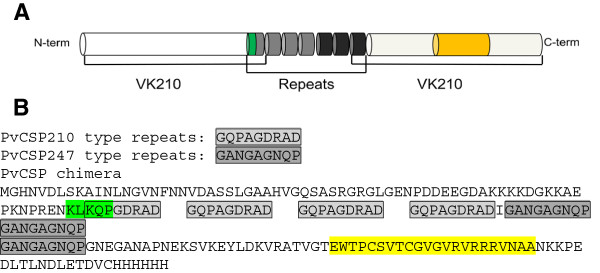
Protein structure (not drawn to scale) and amino acid sequence of the recombinant PvCSP molecule. The repeat region is flanked by N-terminal and C-terminal conserved regions based on the VK210 sequence. The central region represents four VK210 repeats (grey) and three VK247 repeats (black), region I and region II indicated with green and yellow respectively (A). Totally, 205 amino acids consist of this PvCSP chimera including four VK210 repeats (gray), three VK247 repeats (dark), region I (green) and region II (yellow) (B).